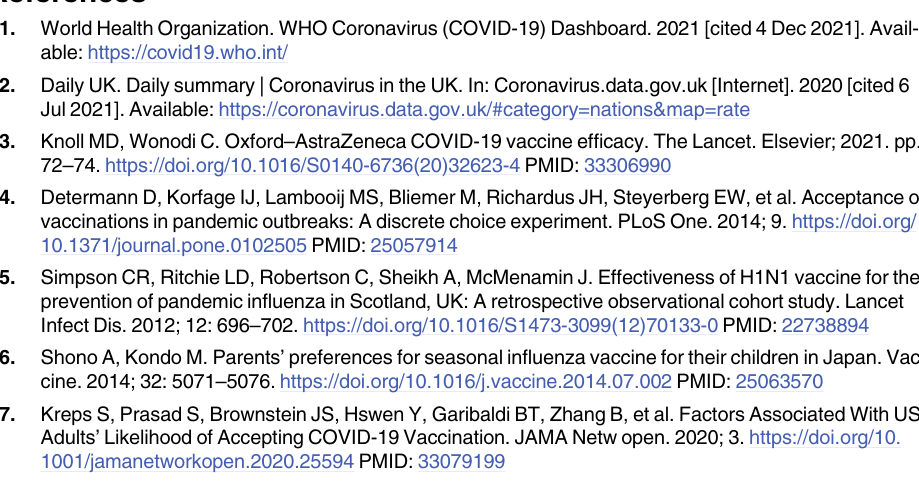
S1 Table. Comparative demographics. Note : Comparisons are made between our survey sample and the 2020 American National Election Study and 2018 General Social Survey. All Census figures taken from the 2018 American Community Survey.